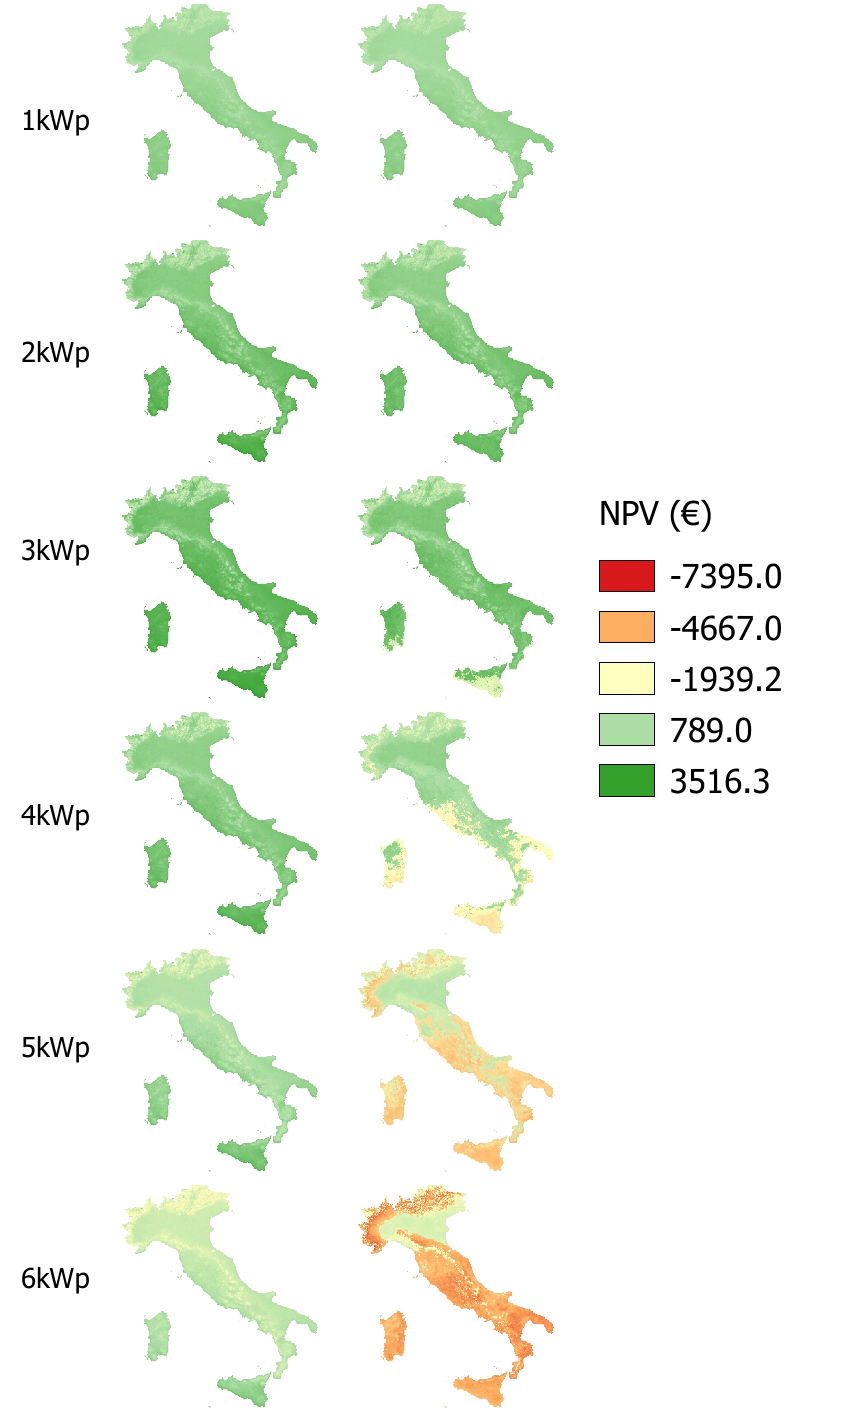
Figure A13. NPV for E L = 4000 kWh, left side without battery and right side with